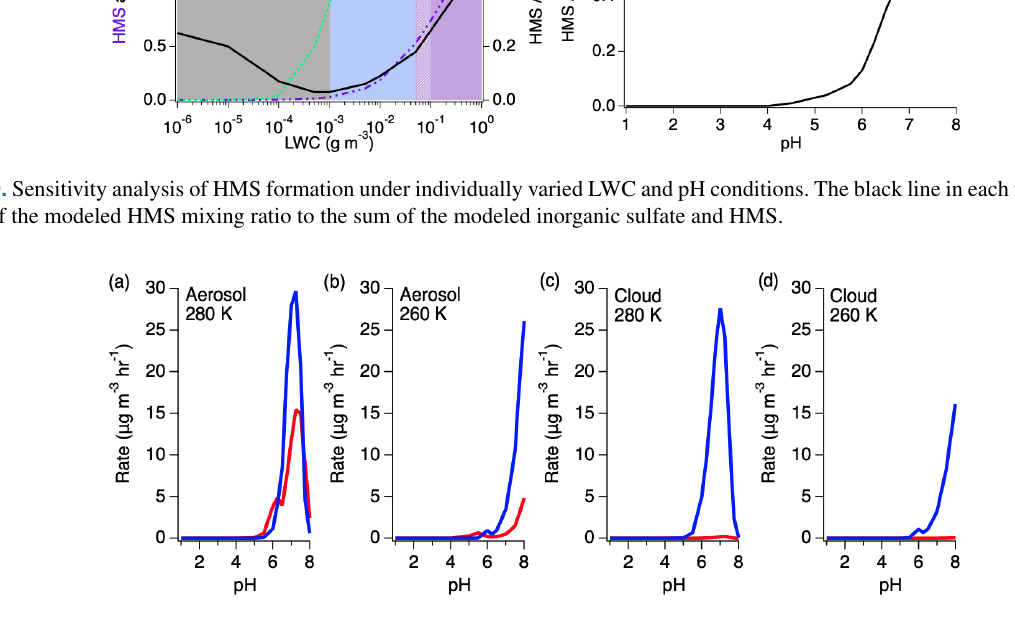
Figure 11. Rates of HMS production (red) and reversal (blue) under aerosol and cloud conditions at 280 and